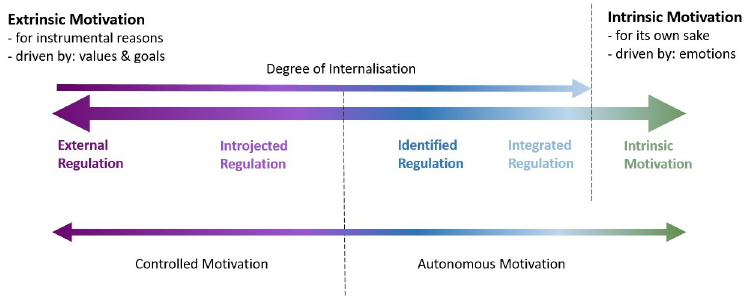
Fig 1. The motivation continuum. (Created by the author, based on